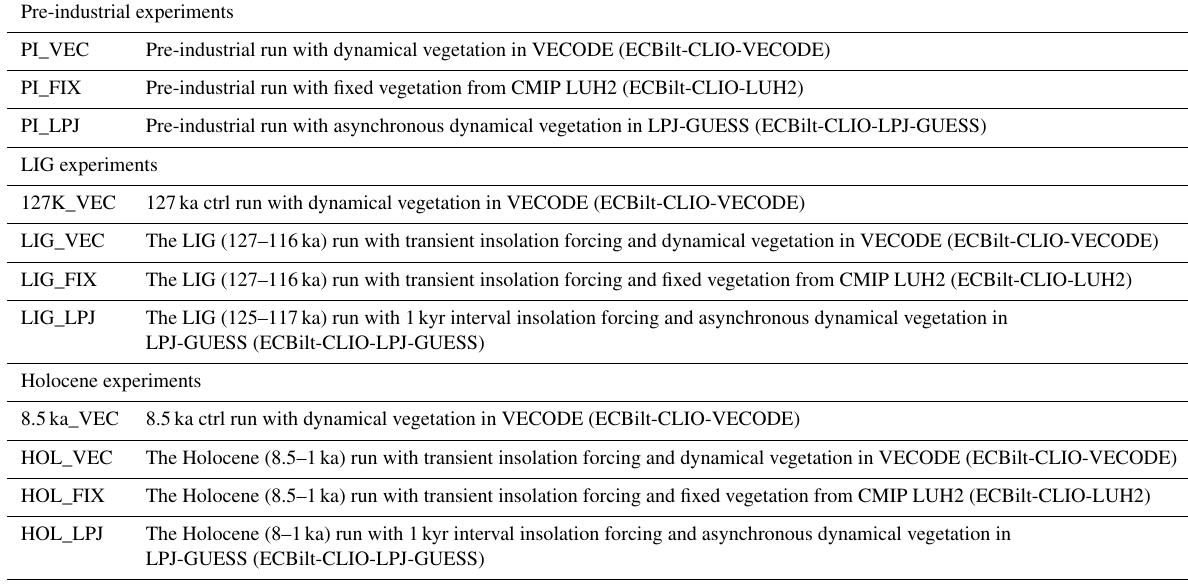
Table 1. Overview of the performed experiments. Pre-industrial